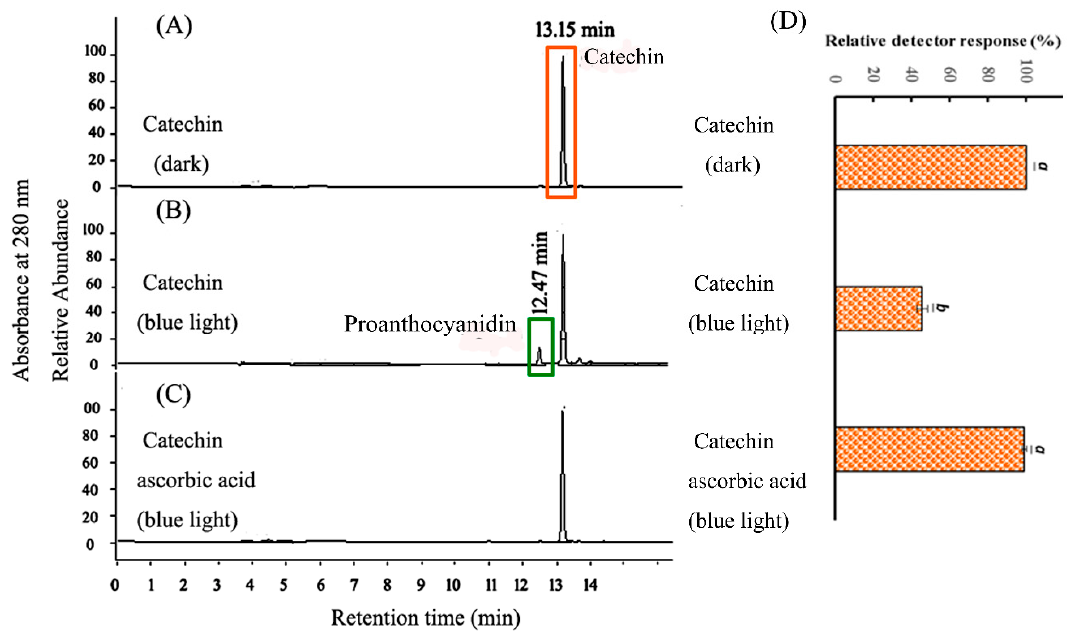
Figure 3. Chromatograms of HPLC-photodiode-array detector (DAD) analysis of ( A ) 290 µ g/mL CHPB (pH 8) in the dark; ( B ) 290 µ g/mL CHPB treated without and ( C ) with 8.8 µ g/mL ascorbic acid, respectively, followed by blue light irradiation at 2.0 mW/cm 2 for 120 min. ( D ) The relative contents of catechin under A, B, and C treatments. Data are represented by mean ± SD, where n = 3. Statistical differences ( p < 0.05) between the groups are indicated by different letters above each bar.